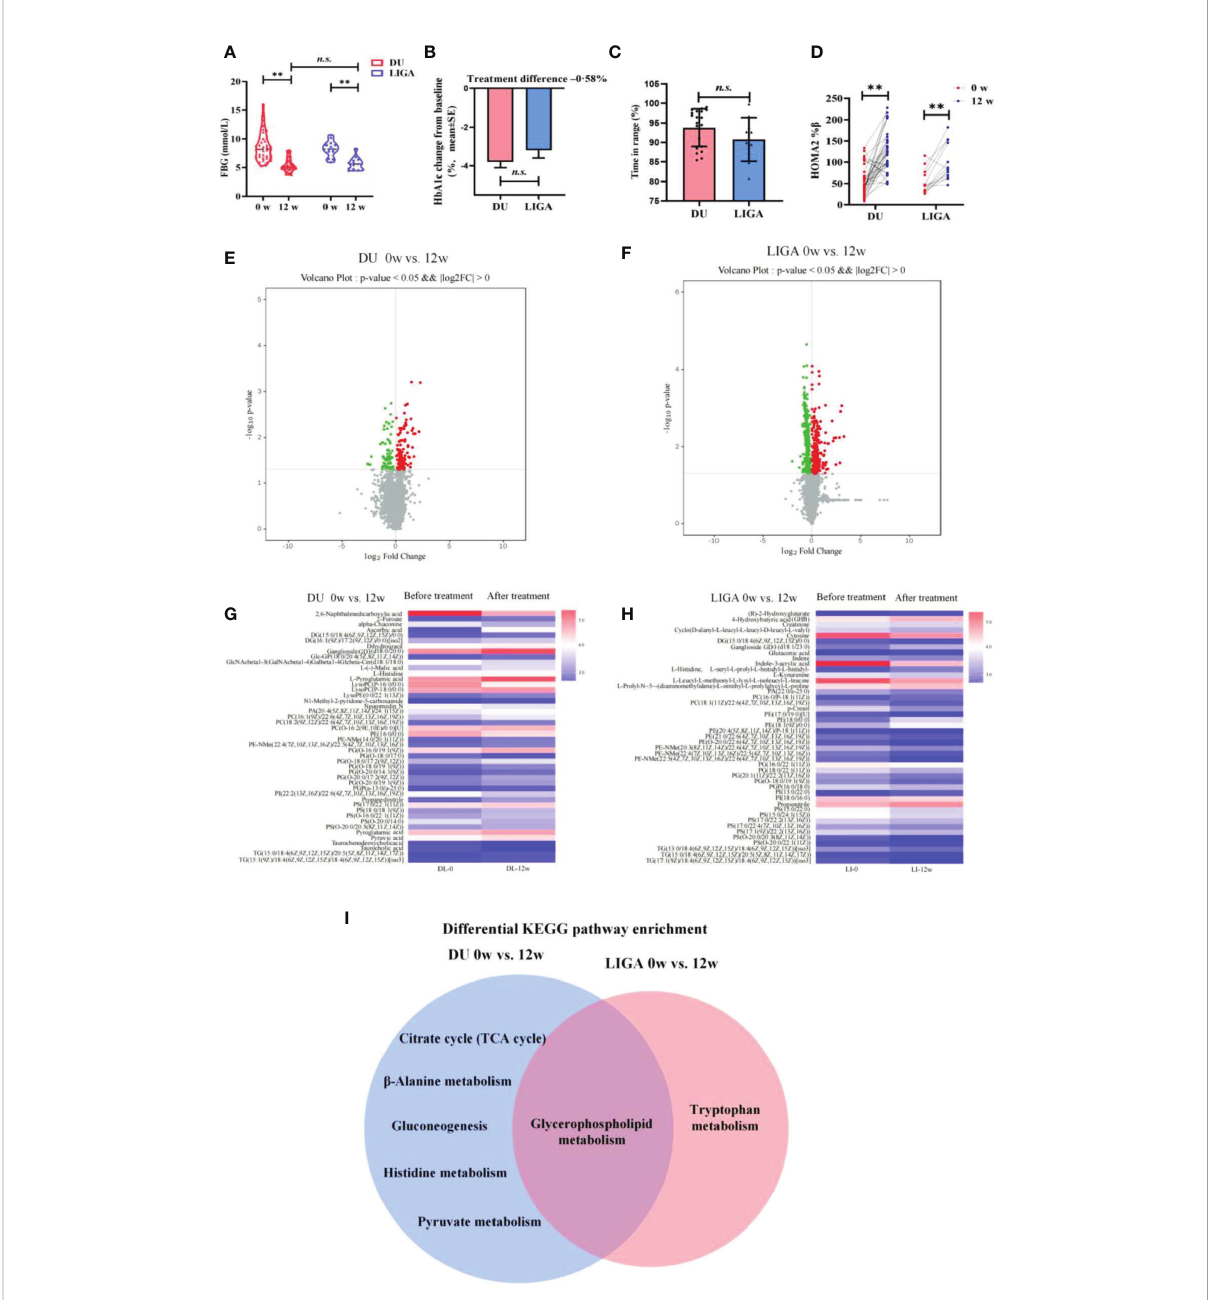
FIGURE 4 Cross-sectional analysis of metabolome changes in response to GLP-1RAs and implications for glycerophospholipid metabolism remodeling. (A) The levels of FBG at baseline and 12 weeks after treatment. (B) The decreasing levels of HbA1c after treatment with DU and LIGA at baseline and 12 th weeks. (C) Comparison of the quality of the glucose control, as evaluated by the percentage of time in the range of 8.0 to 10.0mmol/L. (D) Change in HOMA2% b index after treatment with DU and LIGA at baseline and 12 th week. (E) Volcano plot of -log 10 p-value against log 2 -fold change of 46 metabolites in the DU group at baseline and 12 th week. (F) Volcano plot of -log 10 p-value against log 2 -fold change of 45 metabolites in LIGA group at baseline and 12 th week. (G, H) Comparison of differential metabolites before and after treatments in the DU and LIGA groups. Fold changes are log transformed and indicated by color scale in matrix. (I) Venn diagram depicting KEGG pathway analysis of differential metabolites in the DU and LIGA groups. Differences between T2D and CTL were tested by independent sample t test (normally distributed variables). **p < 0.01. n.s. the difference is not statistically signi fi cant. BMI, body mass index; FBG, fasting blood glucose; HbA1c, glycated hemoglobin; DU, dulaglutide; LIGA, liraglutide; HOMA2% b , the Homeostasis Model Assessment (HOMA) estimates steady state beta cell function (% b